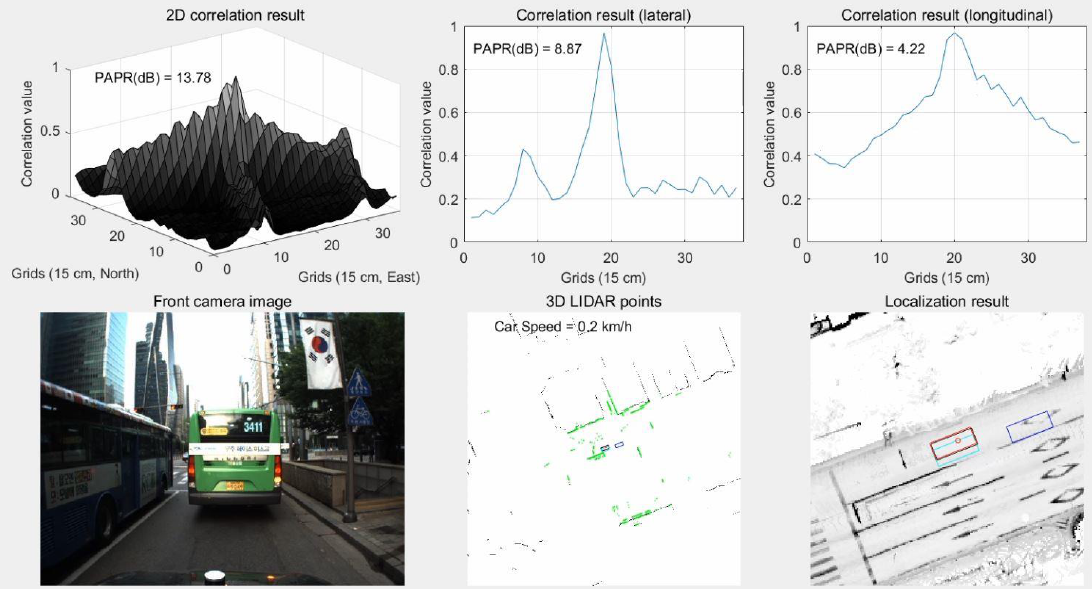
Figure 30. Results of localization using vertical structures in area with traffic congestion.